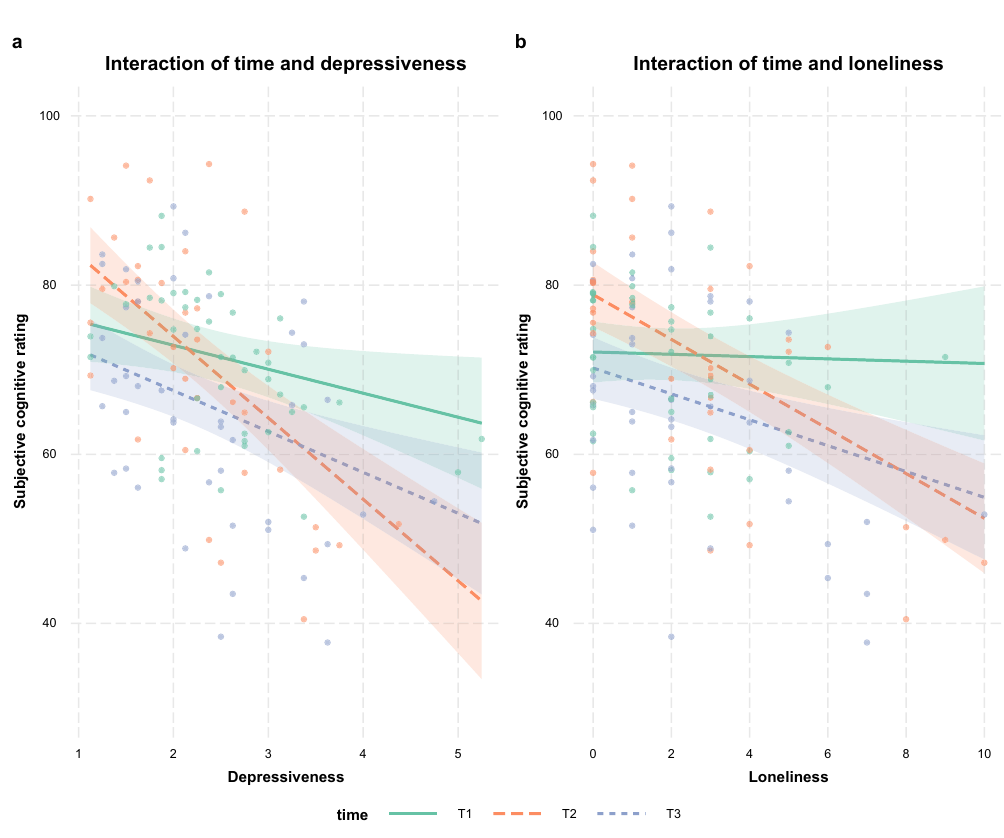
Figure 3. Influence of depressiveness and loneliness on subjective cognitive rating. (a) Interactions of depressiveness and time. (b) Interaction of loneliness and time. Seven influential data points were removed for the respective